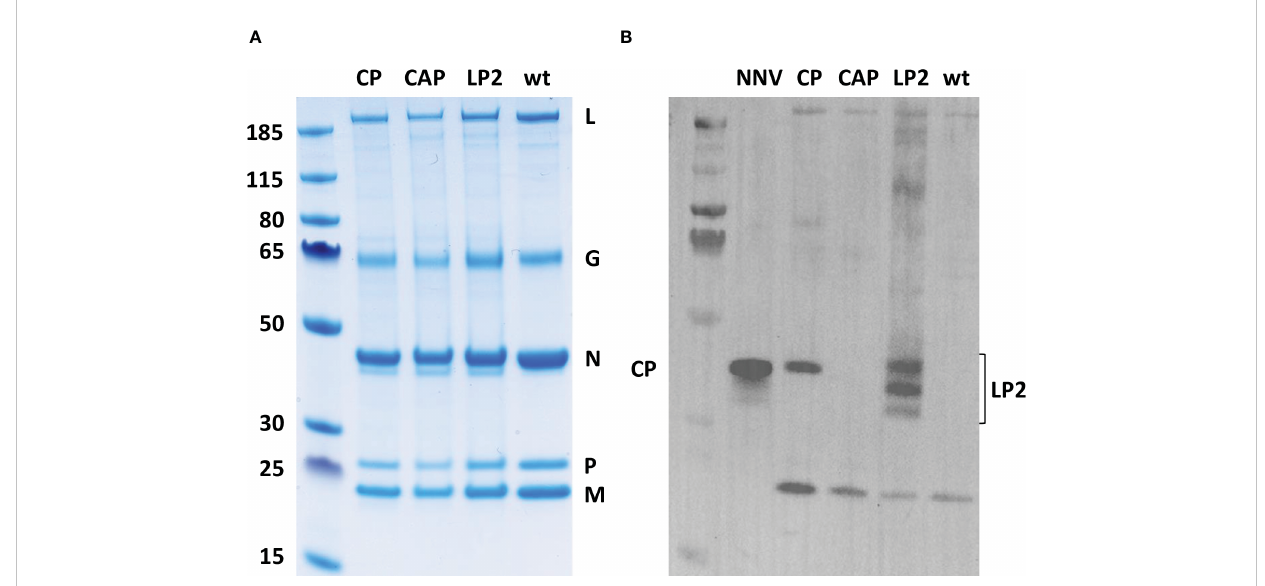
FIGURE 3 Analysis of NNV antigens incorporation in recombinant virus particles. (A) Six micrograms of sucrose-puri fi ed viral proteins were separated on a 4-12% polyacrylamide gel and stained by Coomassie blue. (B) Two micrograms of sucrose-puri fi ed viral proteins were denatured, loaded and migrated on an SDS page gel. The gel was electrotransferred onto a PVDF membrane and NNV antigens were detected with a rabbit pAb directed against